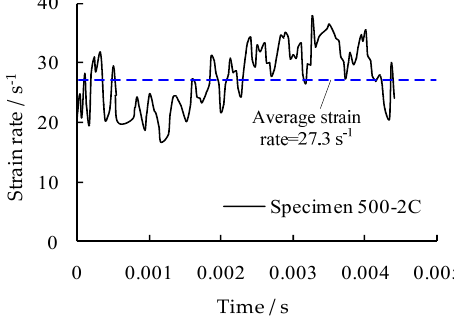
Figure 3. Strain rate vs. time curve for specimen 500-2C.